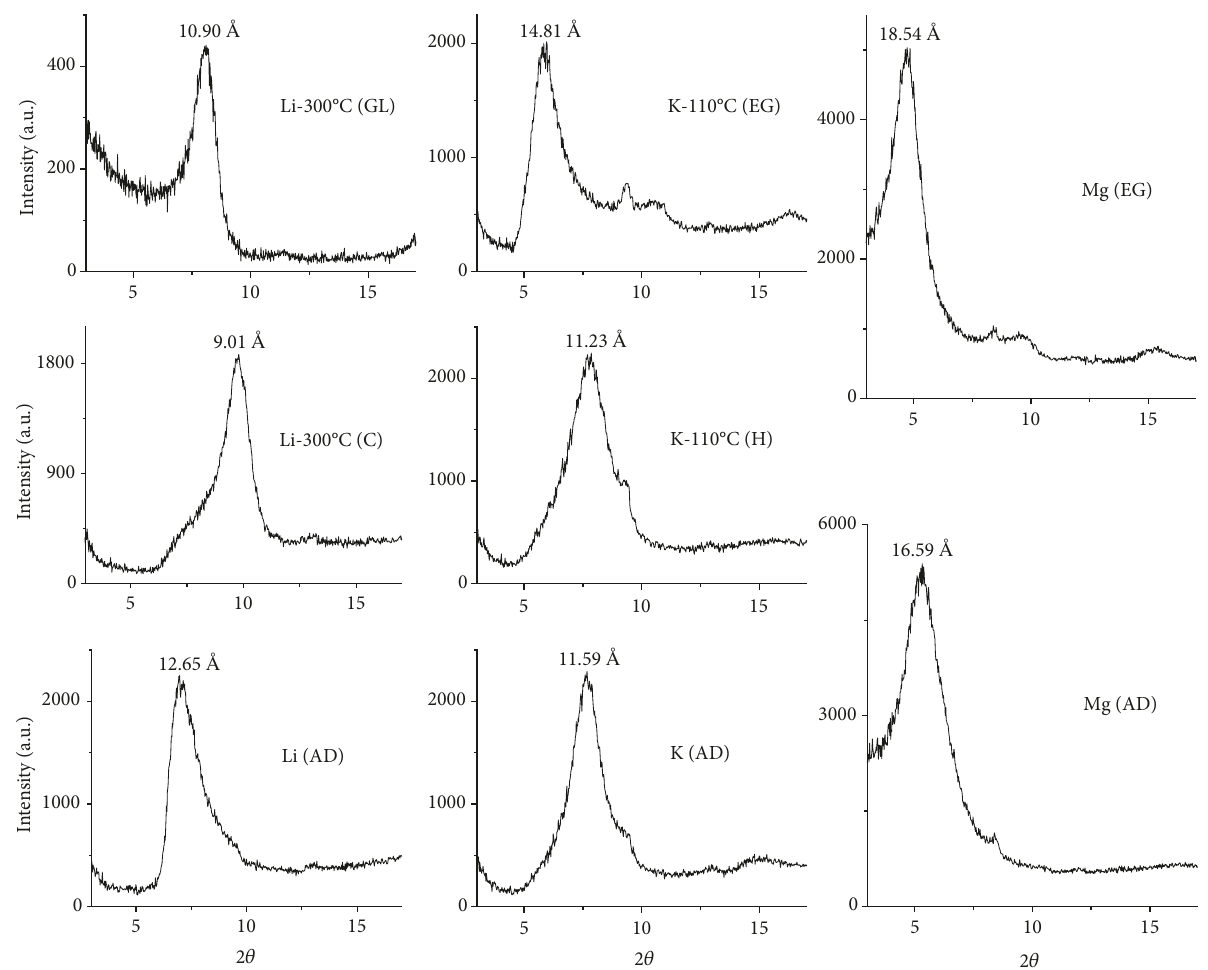
Figure 4: XRD pattern the clay fraction < 2 𝜇 m (oriented mounts) treated with solutions of Li, K, and Mg. AD: air dried; EG: ethylene glycol; GL: glycerol; H: heating; C: